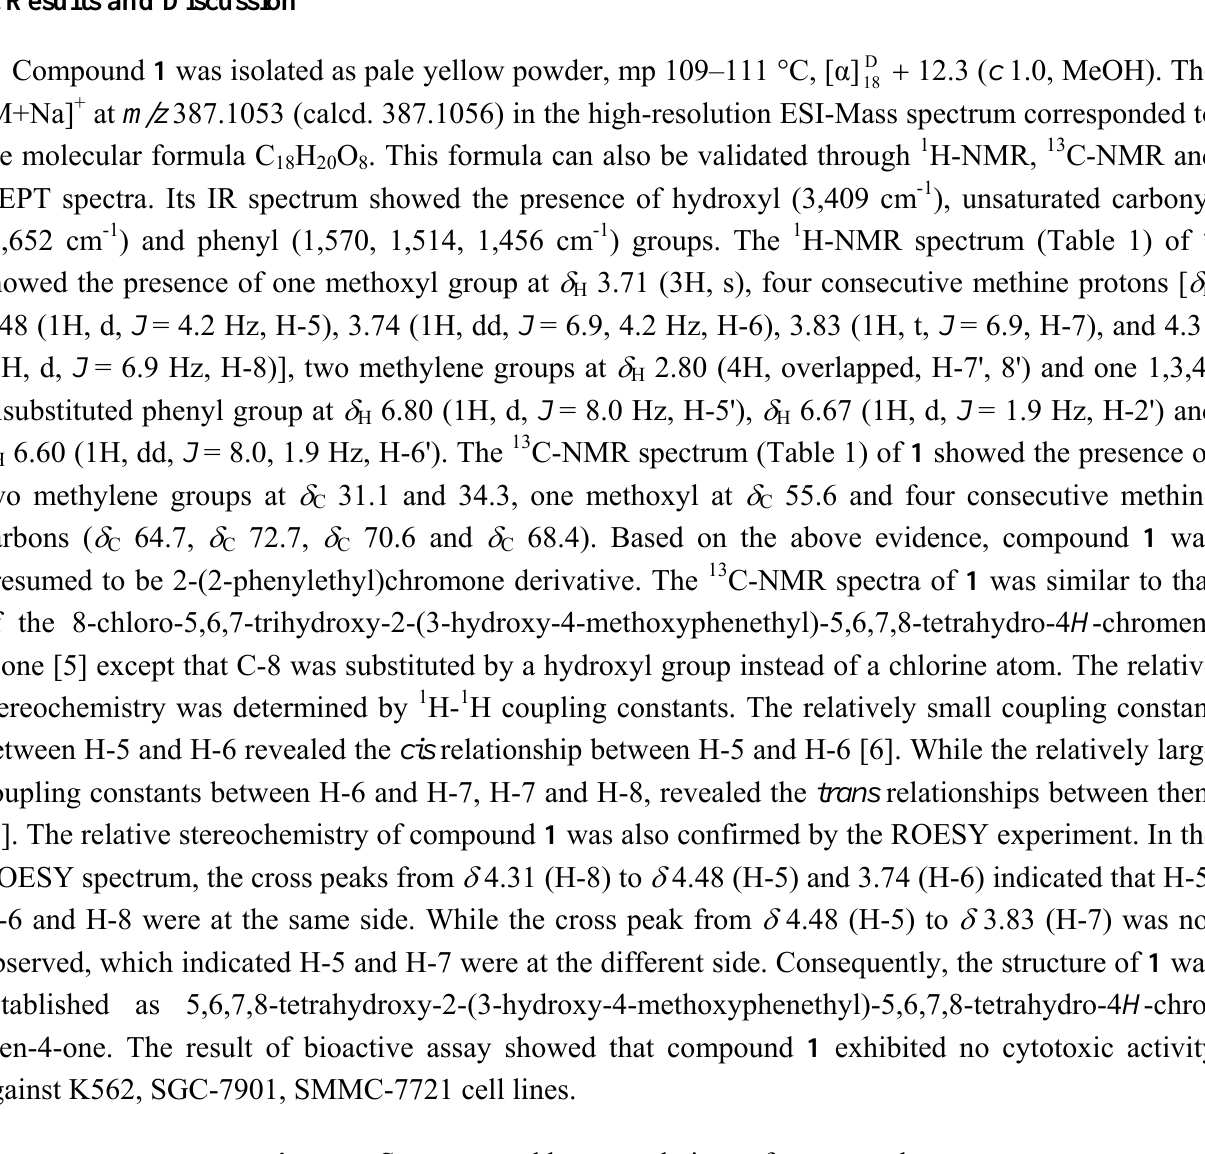
Figure 1. Structure and key correlations of compound 1